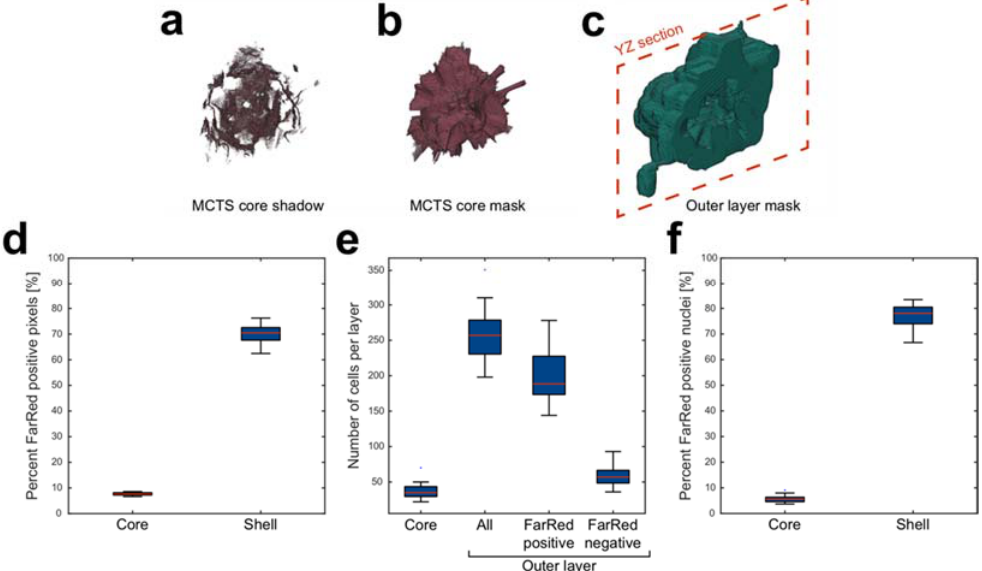
Figure 5. Edge ‐ line analysis enables core and shell segmentation for content analysis. The outer edge points of the MCTS core (MCTS core shadow) was detected by identifying the first Far Red positive voxel in each edge-center line ( a ) and used to create a core mask ( b ). The full MCTS volume subtracted by the core mask was used to define the shell mask (centrally placed void illustrates the border between shell and core in the YZ plane marked by a dashed red line) ( c ). The ratio between far red positive voxels and the total amount of voxels was calculated ( d ) and the numbers of cells in the core, shell, far red positive and far red negative parts of the shell were estimated by dividing the total DAPI volume by the median nucleus volume in each compartment ( e ). The number of cells in each compartment was used to calculate the number of cells that was found in the Far Red positive volume ( f ). Boxplots show the 25th and 75th percentiles with a red line marking the median value. The whiskers show the furthest observation 1.5 times the interquartile length away from the box edge while outliers are marked with a blue